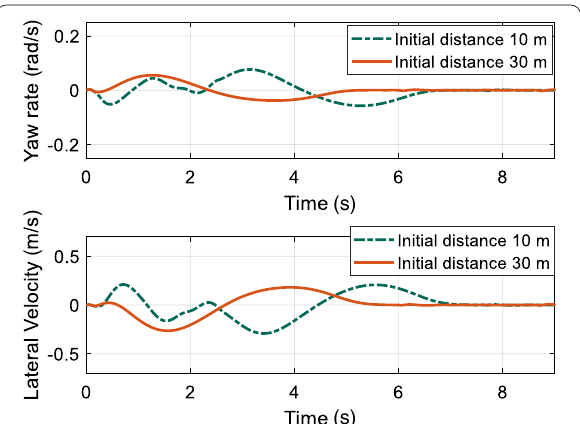
Figure 11 Vehicle positions at the trajectory crossing point when initial longitudinal distance is 10 m